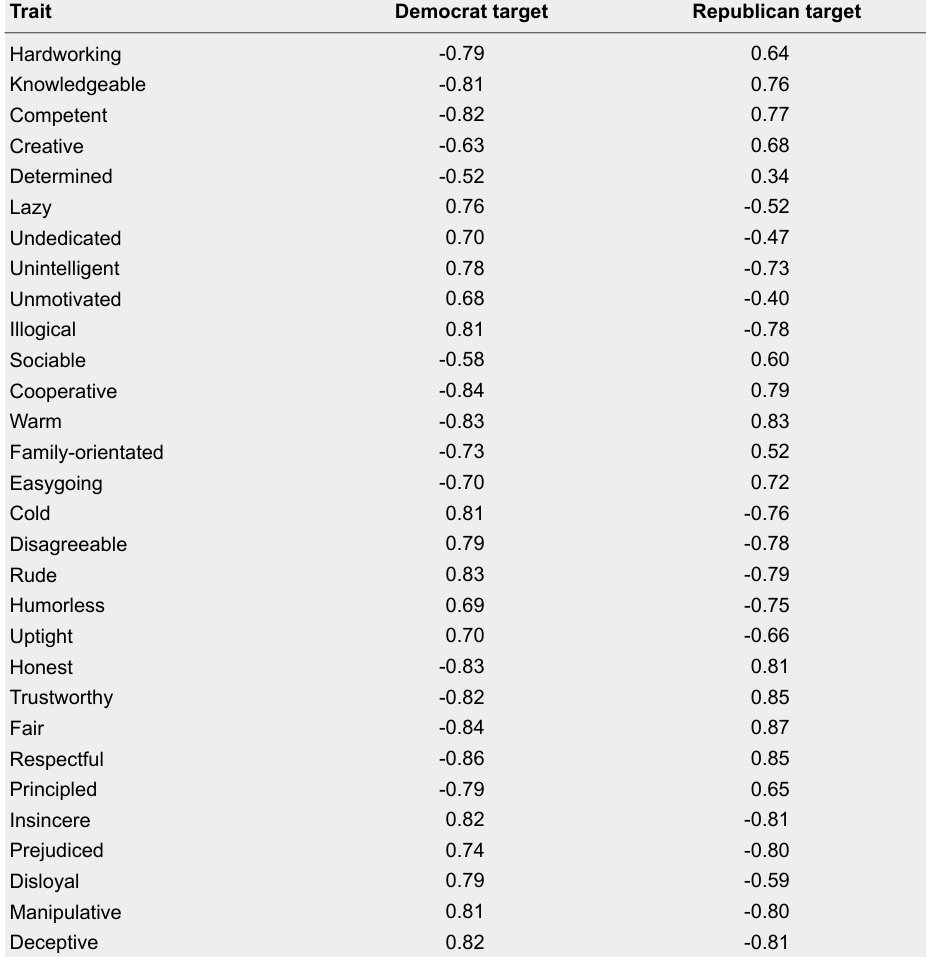
Factor Loadings From Exploratory Factor Analysis (Study